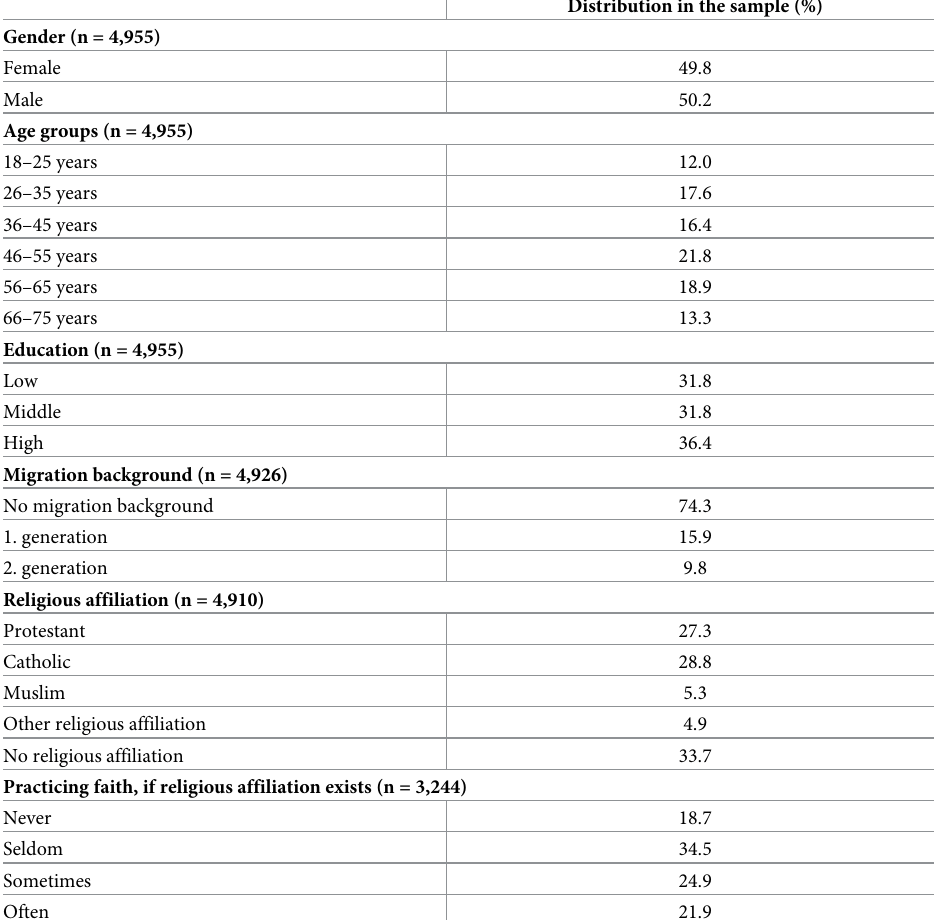
Distribution in the sample